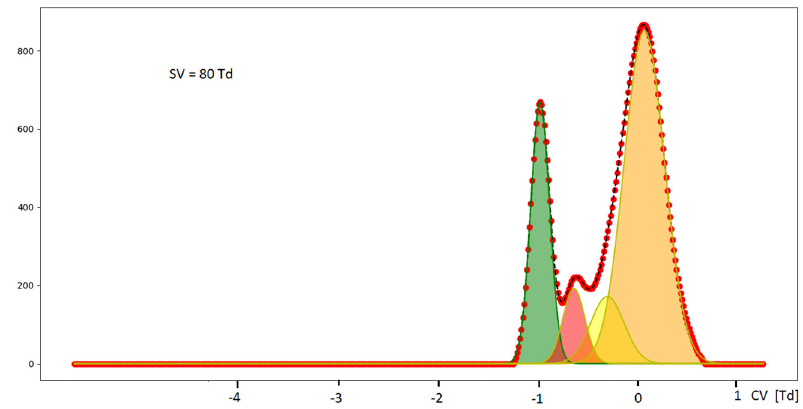
Figure 18. Results of the peak deconvolution program.